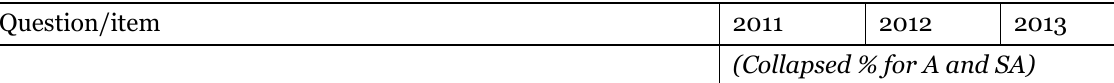
Longitudinal Data and Reticence of 2011 Participants